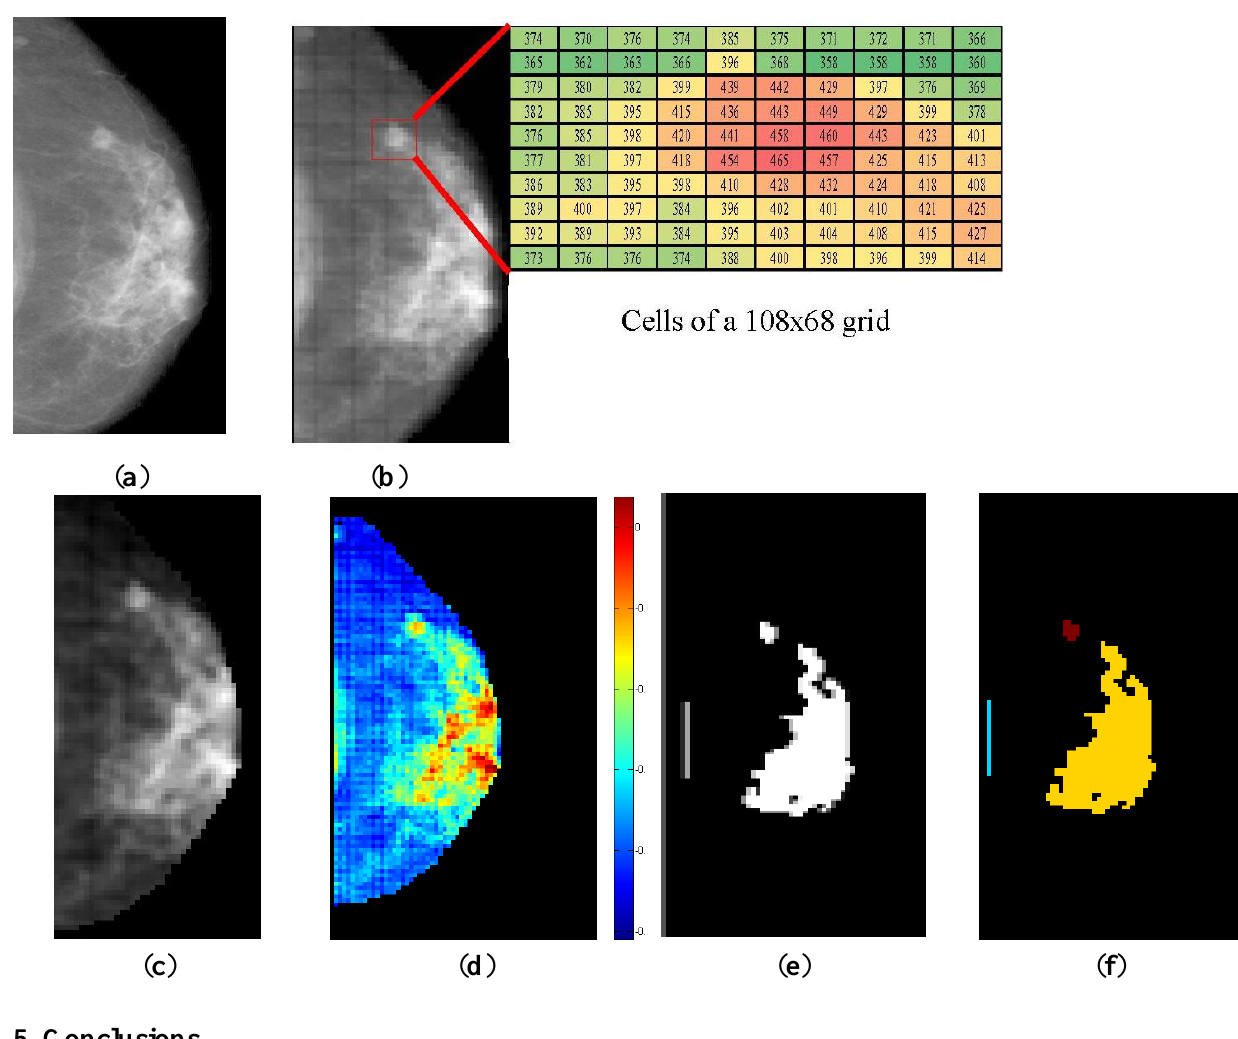
Figure 7. ( a ) a 5386 × 3391 mammogram ( b ) quantized to a 108 × 68 grid by summing local regions of pixels and ( c ) run through a 1-level stationary wavelet transform using the 2.2 biorthogonal wavelet; ( d ) A difference map between the transformed grid and original grid; ( e ) An 80th percentile density threshold is applied, tiny clusters are eliminated through morphological opening; and ( f ) connected components are merged to form three distinct